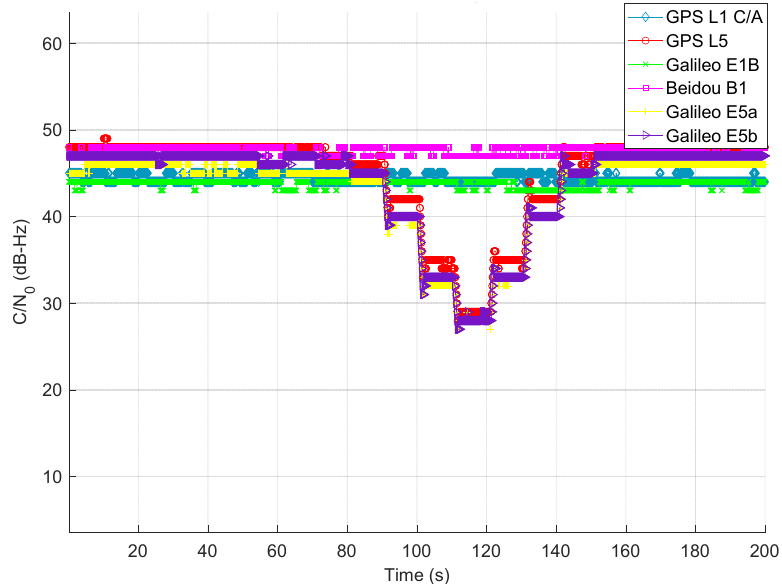
Figure 8. Average C/N 0 of tracked GNSS signals during the presence of jamming on L5/E5a/E5b signals.